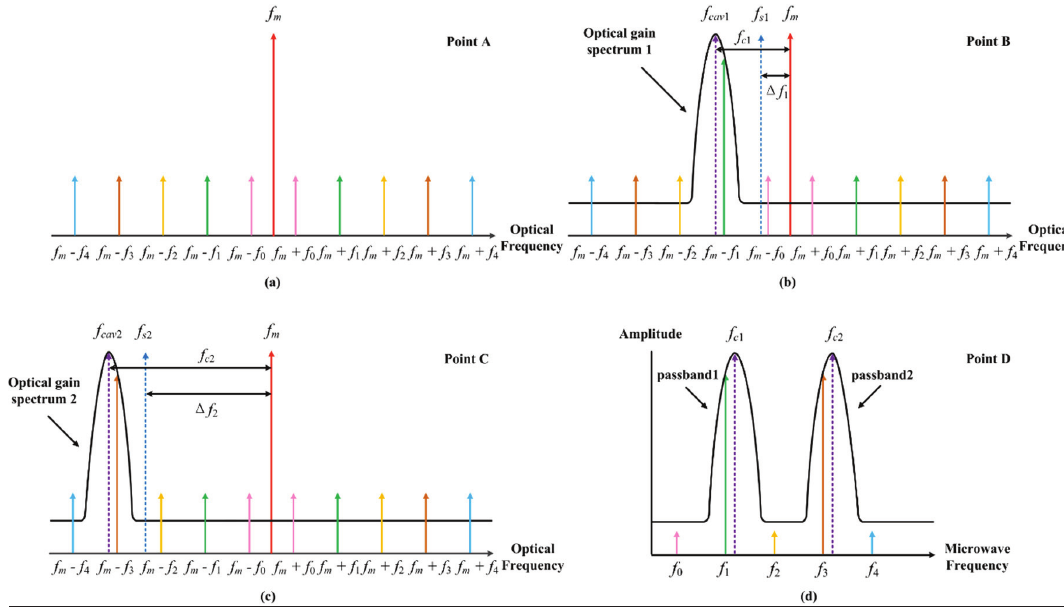
Figure 2. Principle of the tunable dual-passband MPF. ( a ) is the optical spectrum at point A; ( b ) is the optical spectrum at point B; ( c ) is the optical spectrum at point C; ( d ) is the electrical spectrum at point D after the signals’ beating in BPD.